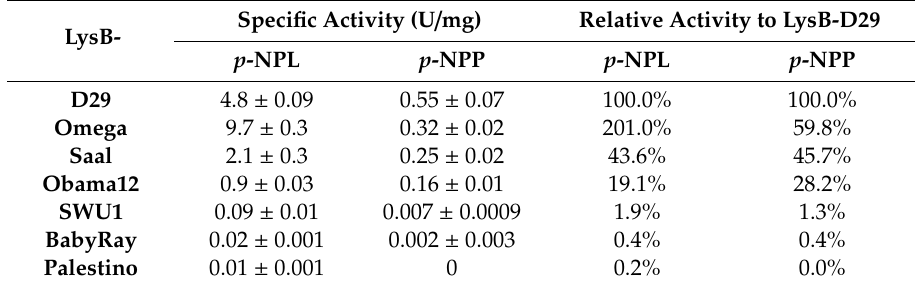
Table 3. Activities of LysB enzymes with p -nitrophenyl laurate ( p -NPL) and p -nitrophenyl palmitate ( p -NPP)